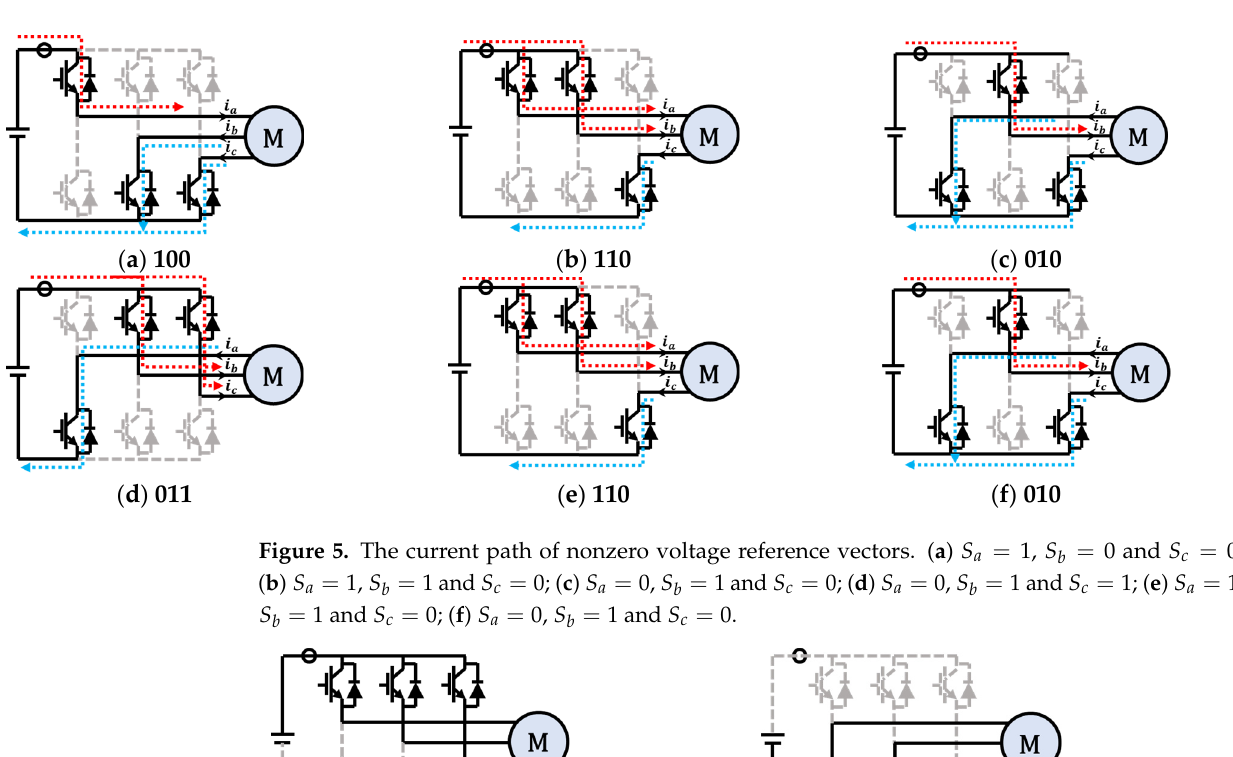
Figure 4. Voltage reference vector in different regions and the output current.